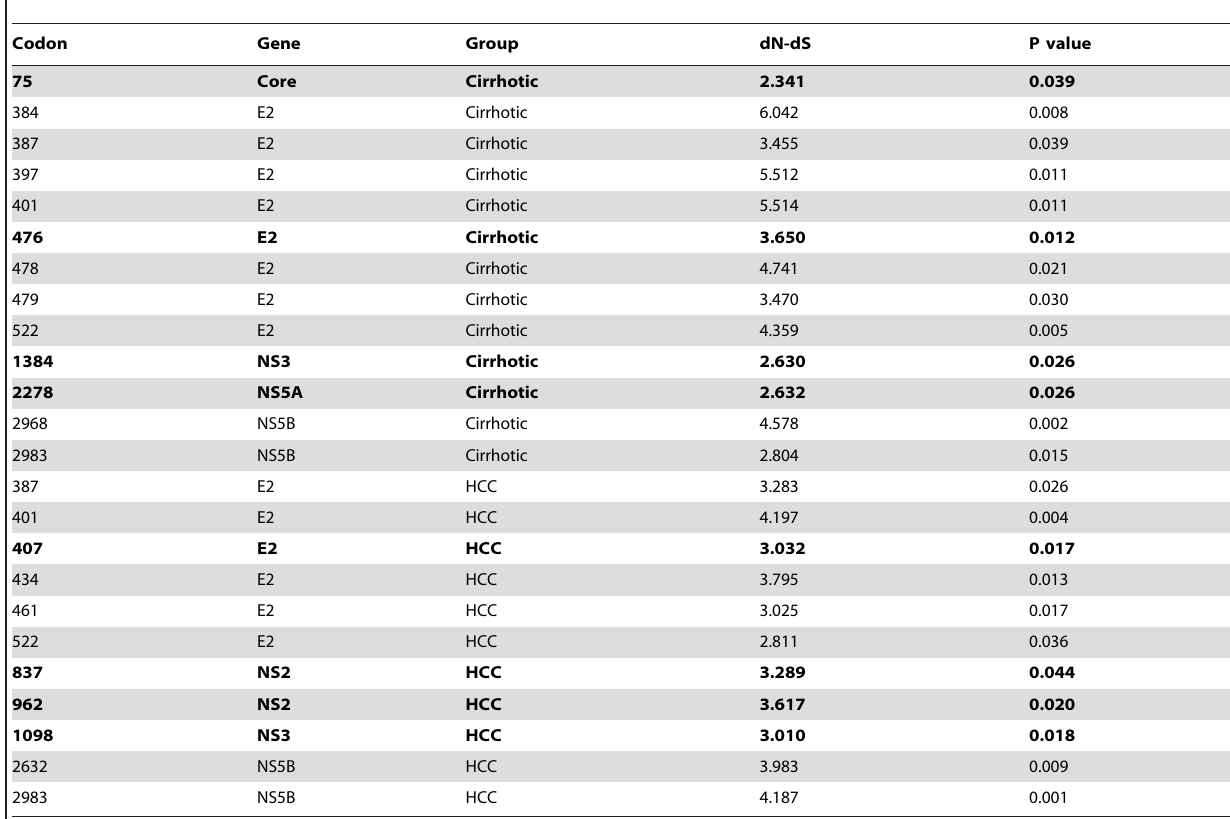
Table 3. Codons under positive selection in the HCC and cirrhotic control sequences.